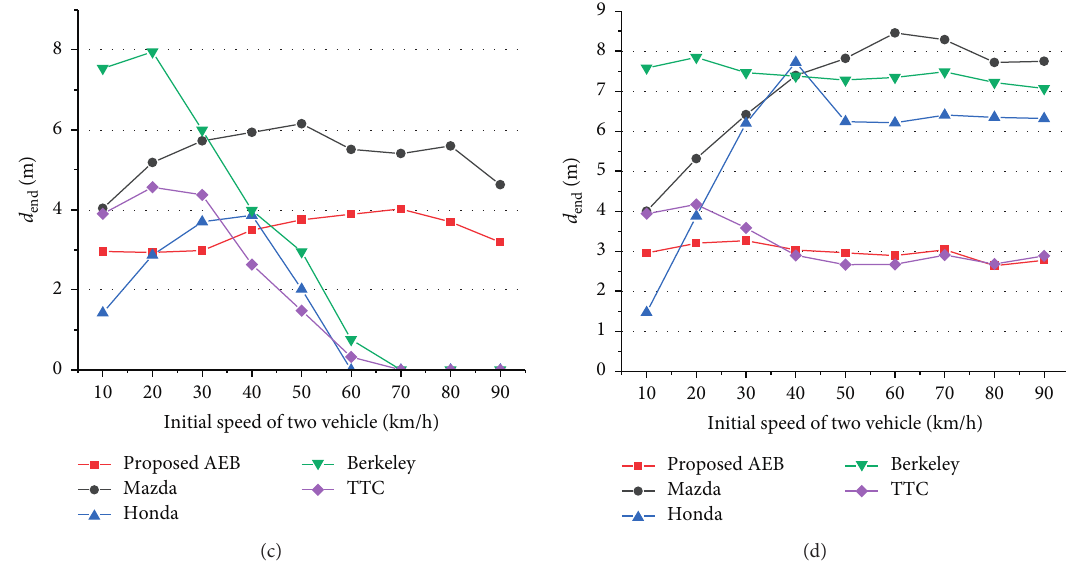
Figure 9: The shortest relative distance between two vehicles in the CCRb scenario test: (a) CCRb-40 m emergency braking intention; (b) CCRb-40 m normal braking intention; (c) CCRb-12 m emergency braking intention; (d) CCRb-12 m normal braking intention.